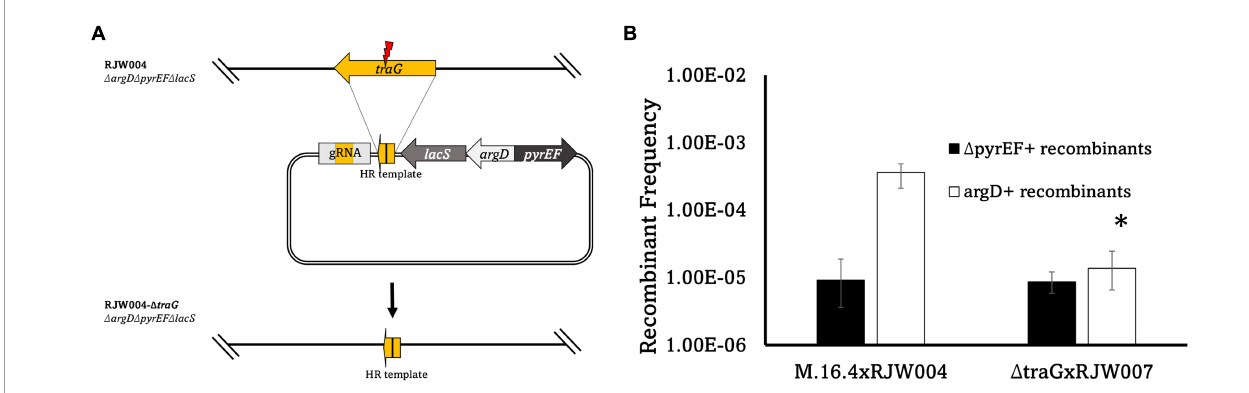
FIGURE4 (A) Schematic diagram of traG gene deletion based on CRISPR-Cas system in S. islandicus M.16.4. The genome editing plasmid was designed by taking advantage of the native CRISPR-Cas system in S. islandicus to build a gRNA targeting traG . To avoid marker recombination, argD from S. tokodaii and pyrEF / lacS from S. solfataricus were utilized instead on native markers. (B) Recombinant frequencies of the traG deletion mutant compared to wild type. Error bars represent highest and lowest replicate for each assay, ∗ represents a p -value of < 0.05 when comparing to M.16.4 argD frequency.